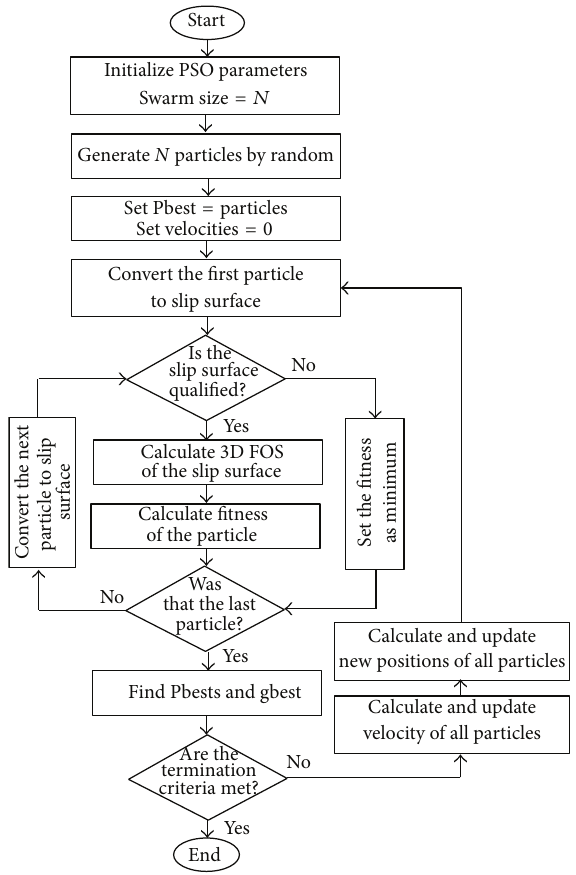
Figure 3: Flowchart of PSO to determine the CSS in slope stability analysis.